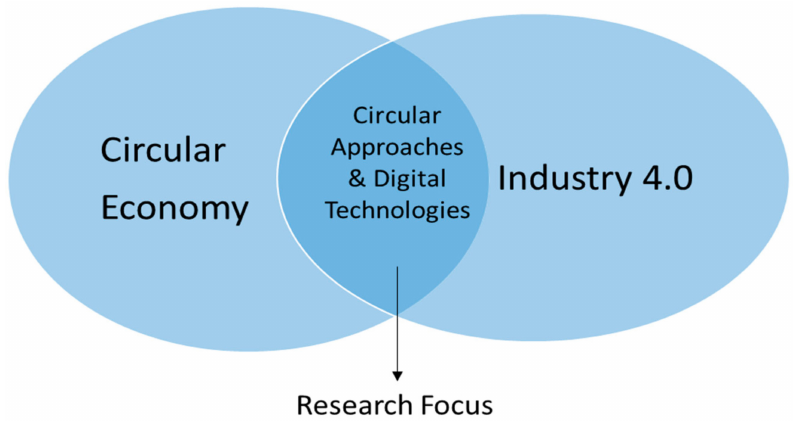
Figure 2. Research Focus for Research